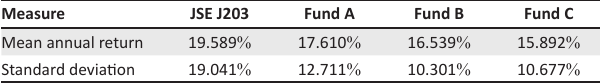
TABLE 2: Mean returns and standard deviation.